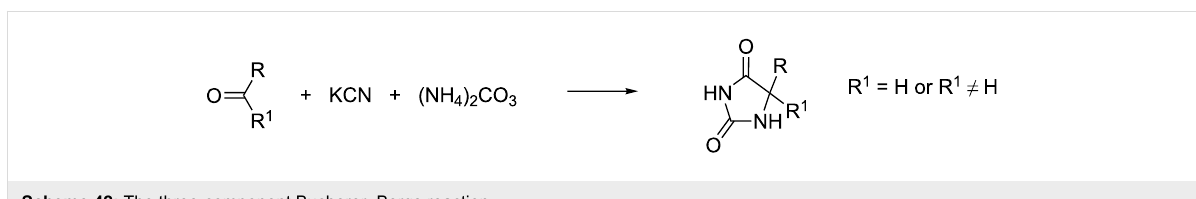
(+)-Hydantocidin (Scheme 43), isolated from